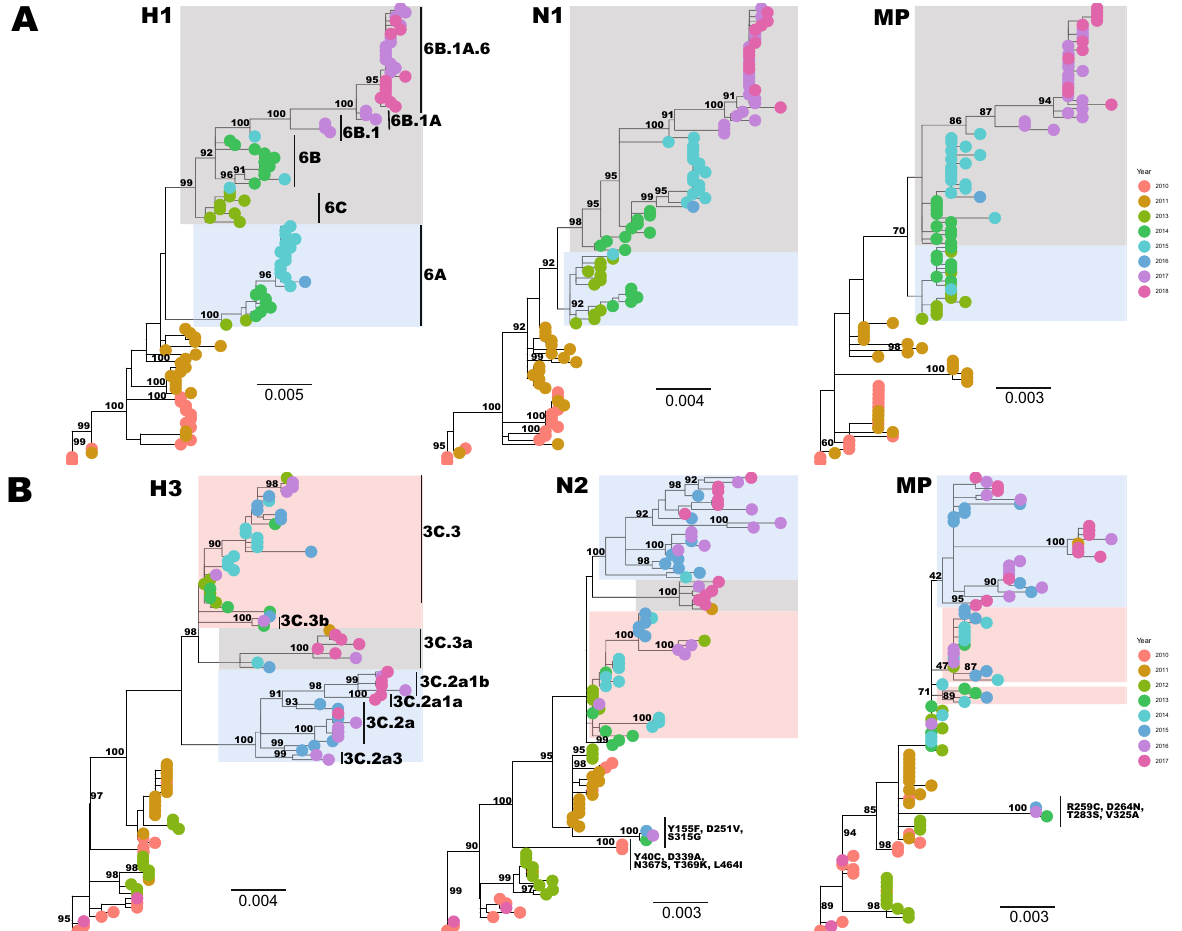
Figure 2. Phylogenies showing the temporal divergence of the HA, NA and MP genes of Uganda A(H1N1) pdm09 ( A ) and A(H3N2) ( B ) influenza viruses sampled from 2010 to 2018. Trees were rooted using the oldest sequence in the dataset. Shaded clusters are the two and three major co-circulating lineages observed since 2013 and 2012 for A(H1N1)pdm09 and A(H3N2) viruses, respectively. The third A(H3N2) lineage (with one 2011 and 2016–2017 viruses) disappeared in the MP